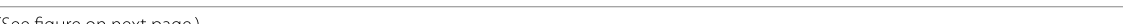
figure on next Fig. 3 Down-regulation of MAPKAPK5-AS1 reduces LPS-induced rat cardiomyocyte apoptosis and inflammation. A Cell viability of H9C2 cells was detected after treated with various concentrations of LPS (0, 0.001, 0.01, 0.1, 1, and 10 ng/mL). B The expression of MAPKAPK5-AS1 in H9C2 cells treated by various concentrations of LPS (0, 0.001, 0.01, 0.1, 1, and 10 ng/mL). C The expression of miR-124-3p in H9C2 cells treated with various concentrations of LPS (0, 0.001, 0.01, 0.1, 1, and 10 ng/mL). D MAPKAPK5-AS1 expression in H9C2 cells transfected by si-NC or si-MAPKAPK5-AS1. E Flow cytometry analysis of apoptosis in cells treated with vehicle, LPS, LPS si-MAPKAPK5-AS1. F Western blot for protein expressions of t-casp3, + c-casp3, t-PARP, e-PARP, Bax, Bcl2, and GAPDH in H9C2 cells treated with vehicle, LPS, or LPS si-MAPKAPK5-AS1. G Western blot for protein + expression levels of IL-1β, MCP-1, IL-6, TNF-α, MMP2, and MMP9 in H9C2 cells treated with vehicle, LPS. or LPS si-MAPKAPK5-AS1. Each column + represents the mean SEM. Statistical differences were evaluated with One-way ANOVA followed by Tukey’s post-hoc test. *P < 0.05, **P < 0.01, ± n =